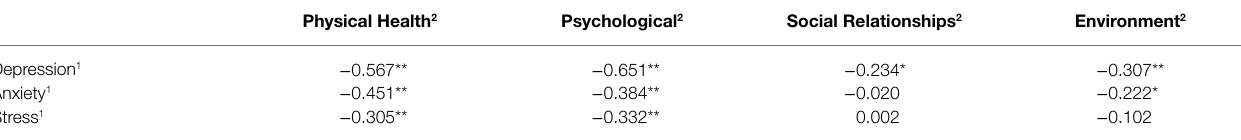
TABLE 4 | Correlations of depression, anxiety, and stress with quality of